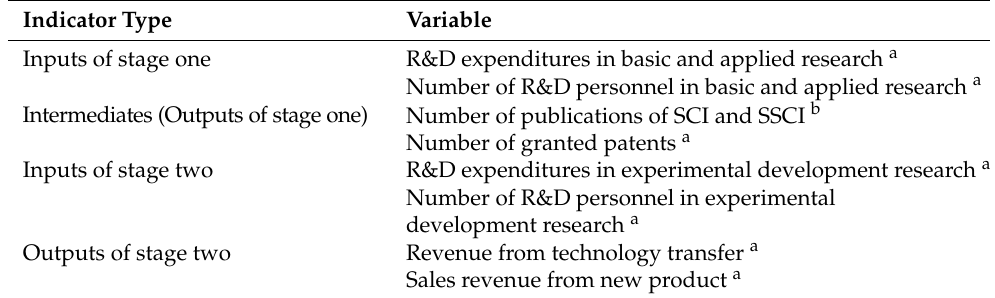
Table 1. Variable selection and data sources.